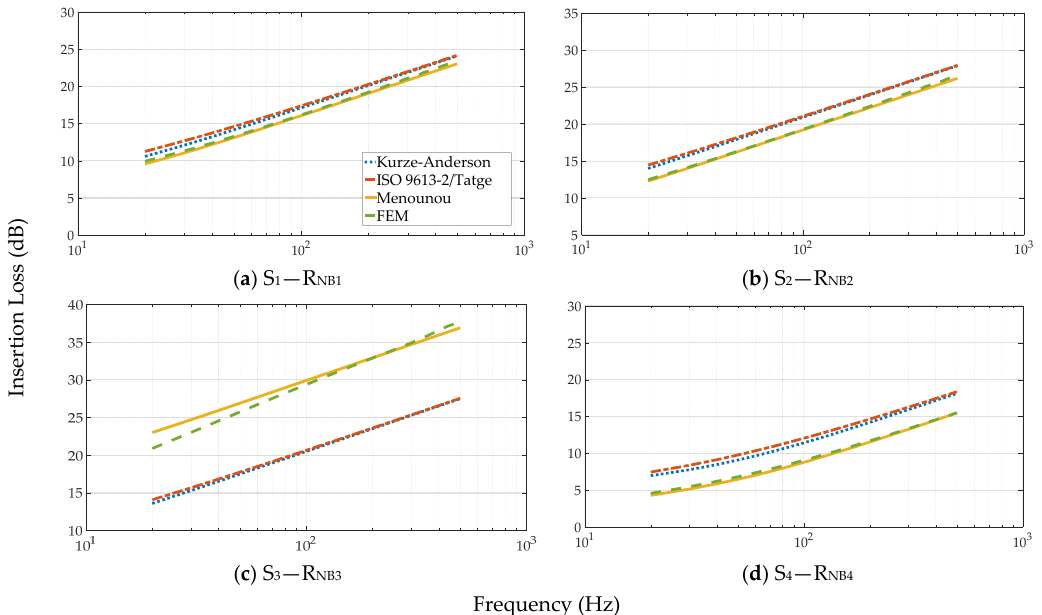
Figure 7. Comparison of calculation of insertion loss between FEM and various formulae for various source and receiver positions near the barrier inside the shadow zone.